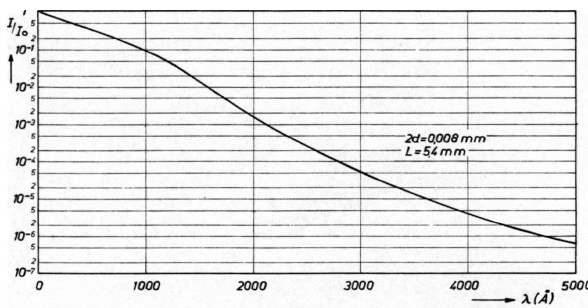
Figure 8. Filter transmission of the arrangement of multiple slits Figure 8: Filter transmission of the arrangement of multiple slits (Figure 7) with slit width of 8 μm and total length of the diffraction filter of 54 mm (Schweizer and Schmidtke, (Fig. 7) with slit width of 8µm and total length of the diffraction fil- 1971, © AAS, reproduced with permission). ter of 54mm (Schweizer and Schmidtke, 1971; ©AAS, reproduced with permission).